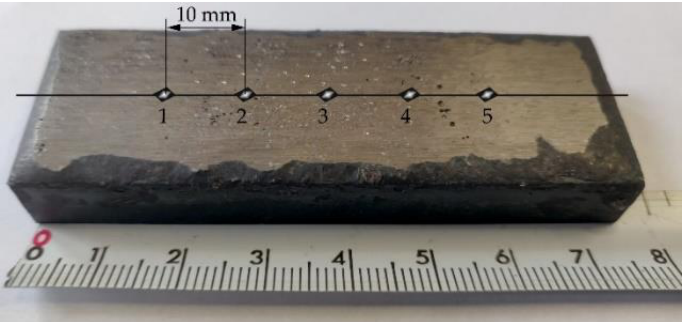
Figure 6. Exemplary locations of measurement points on the surface of the wear resistant layer. The microhardness testing was done using Vickers method HV0.5. The hardness phase and the